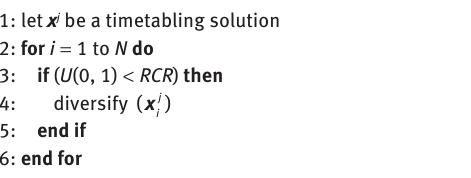
Algorithm 5: Pseudocode of the Random